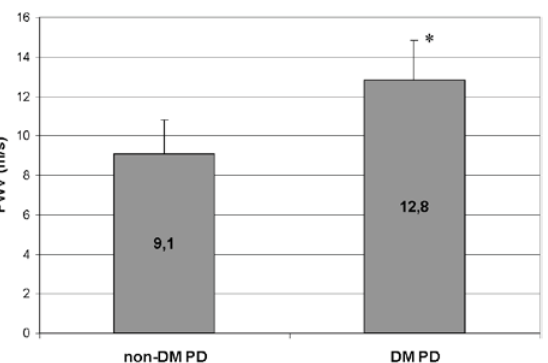
Figure 3. Comparison of carotid-femoral pulse wave velocity in peritoneal dialysis patients without diabetes (non-DM PD) and with diabetes (DM PD) (* p =